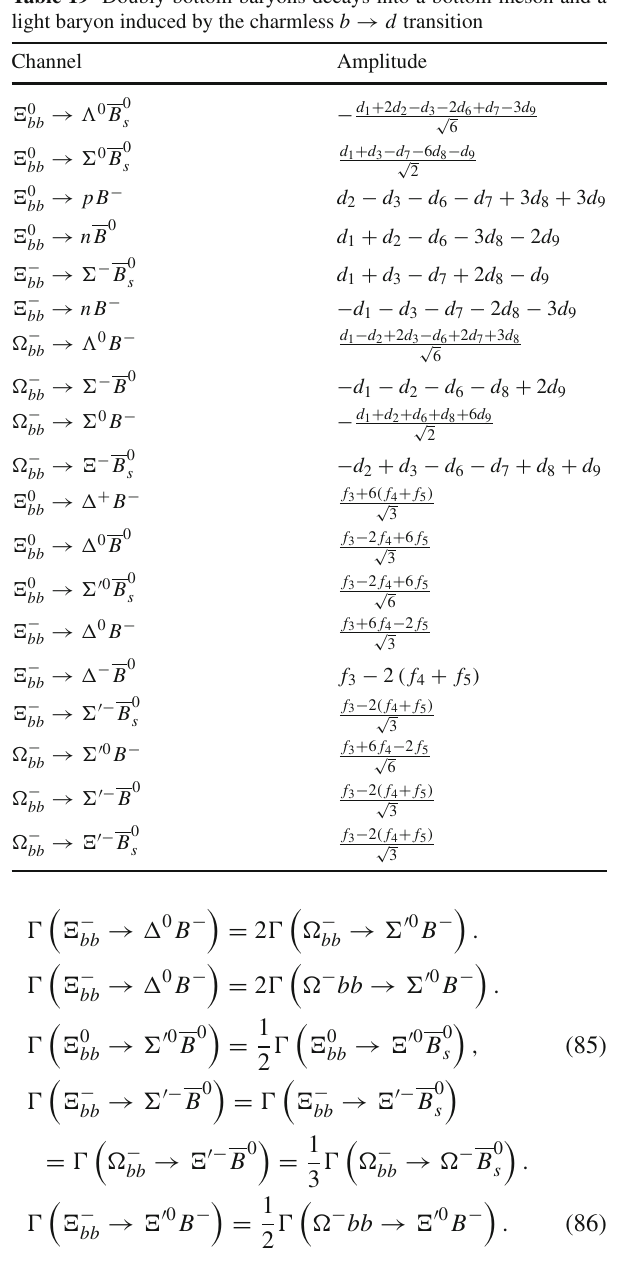
6 Nonleptonic (cid:2) bc and (cid:3) bc